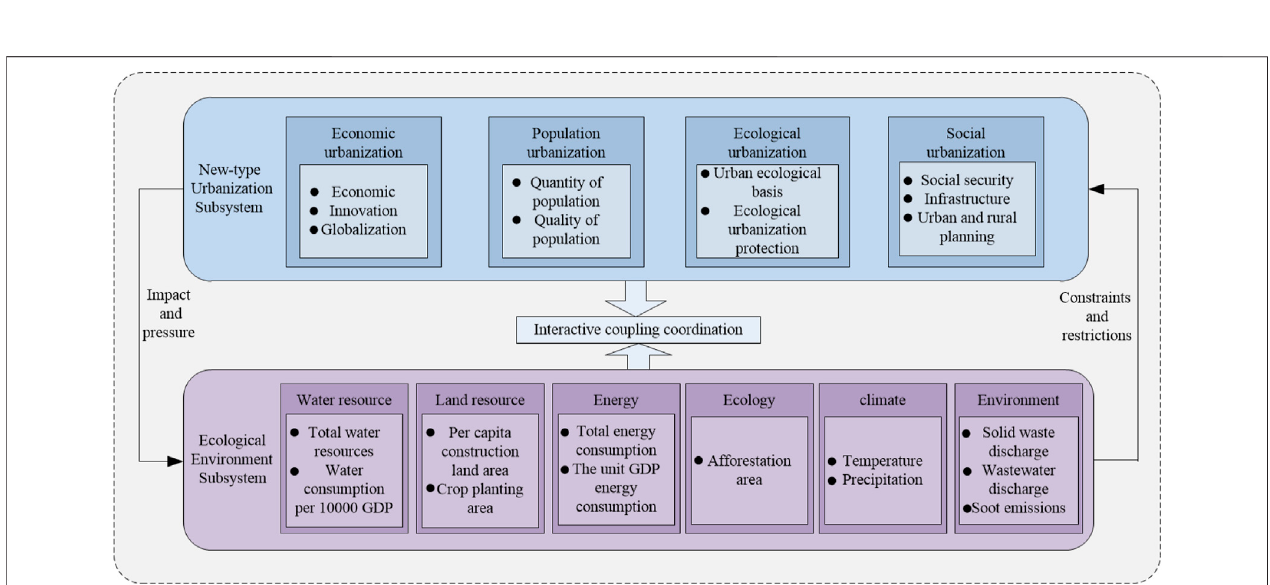
FIGURE 4 | Interactive coercing relationship of the key elements between new-type urbanization and eco-environment in urban agglomerations.